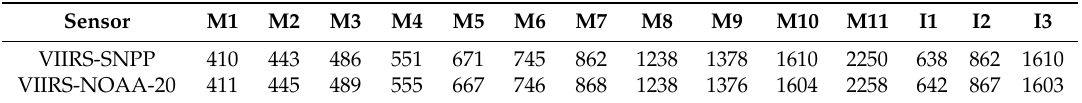
Table 1. The VIIRS reflective solar band (RSB) spectral band nominal center wavelength (in nm) for SNPP and